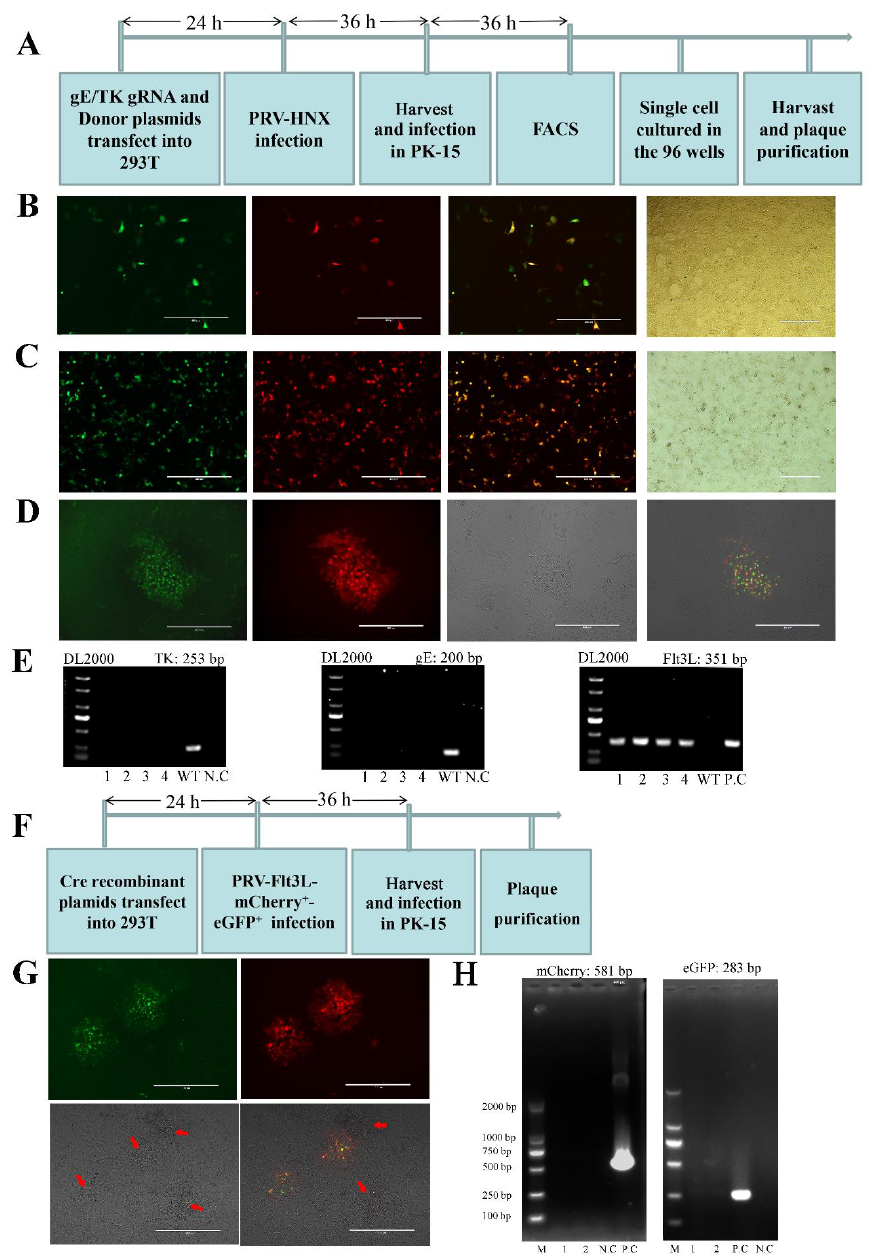
Figure 2. Construction of recombinant HNX-TK − /gE − -Flt3L. ( A ) Process of CRISPR/Cas9-assisted TK and gE gene recombination. ( B ) Single guide RNA (sgRNA) and donor plasmids were co-transfected into 293T cells, and, 24-h post transfection, the cells were infected with PRV HNX strain at 0.01 MOI. After 36 h, fluorescence microscopy was used to observe the fluorescent marker gene expression. ( C ) After single cell FACS, single cells were plated into 96-well plates pre-seeded with PK-15 cells, and, after 24 h, the fluorescence was observed. ( D ) Plaque purification of the recombinant PRV in agarose-DMEM cultured plates. ( E ) PCR verification of the TK, gE, and Flt3L genes. Lanes 1 – 4— HNX-TK − /gE − -Flt3L-mCherry + -eGFP + . N.C., negative control. P.C., Positive control. ( F ) Process of double fluorescent gene excision using the Cre/Lox system. ( G ) Plaque purification for the double fluorescent gene excision virus. Virus plaques are indicated with arrows. ( H ) PCR verification of the mCherry and eGFP genes. Lanes 1,2: HNX-TK − /gE − -Flt3L. N.C., negative control. P.C., Positive